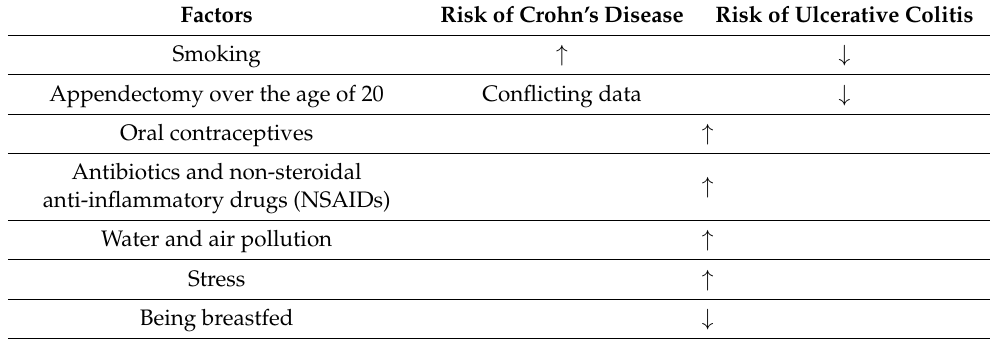
Table 3. Environmental factors influencing the risk of inflammatory bowel